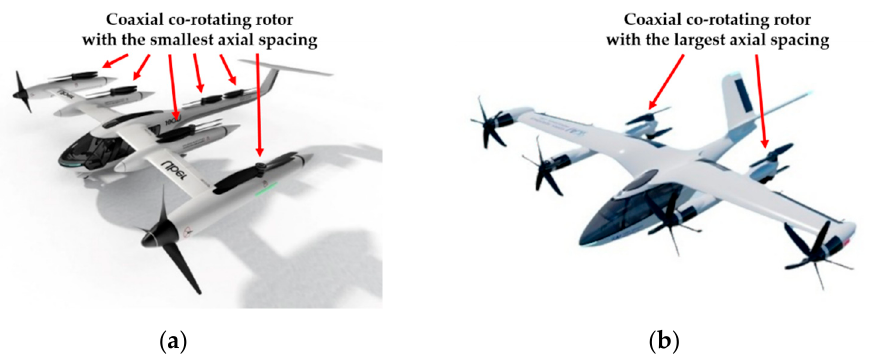
Figure 2. Coaxial co-rotating rotors with different axial spacings for eVTOL aircraft: ( a ) Uber; ( b ) Korea Aerospace Industries.